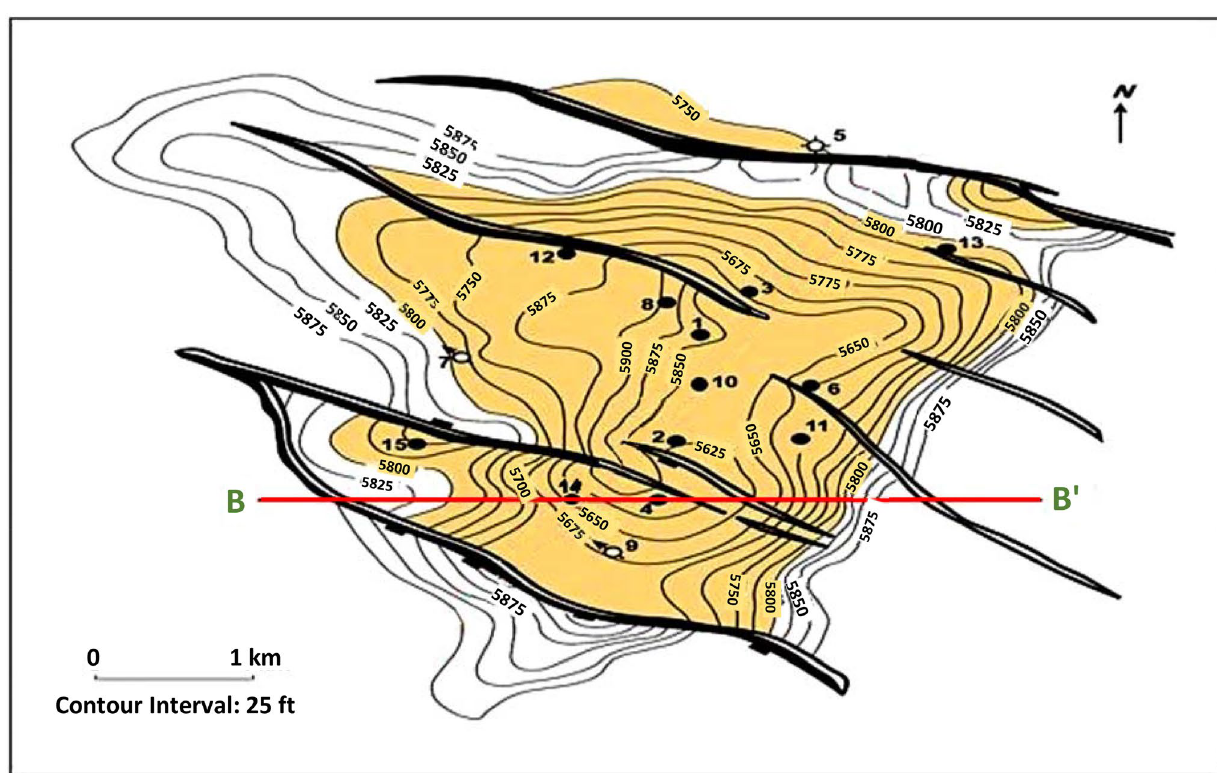
Fig. 5 Structural map on top of the Lower Bahariya Formation, Khalda Field (EGPC, 1992)